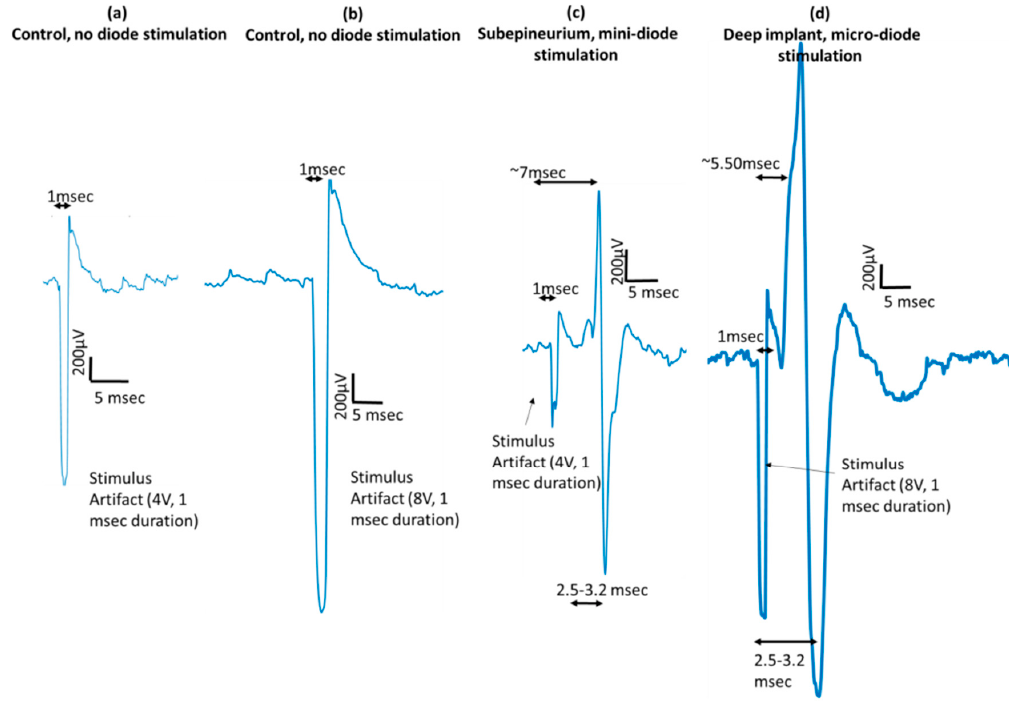
Figure 13. Activation of remote diodes using AC stimulation waveforms induces distinct dose-dependent EMG responses. ( a , b ) EMG responses are not observed in the absence of any diodes to AC stimulation of 4 V and 8 V. ( c ) Distinct EMG peak amplitudes are seen ~7 msec after the stimulus artifact in response to activation of diodes placed subepineurially and ~5.5 msec after stimulus artifact in response to activation of diodes placed deep in the nerve ( d ). These representative EMGs were recorded in response to an AC stimulus of 500 kHz frequency with a 1 msec stimulus duration.